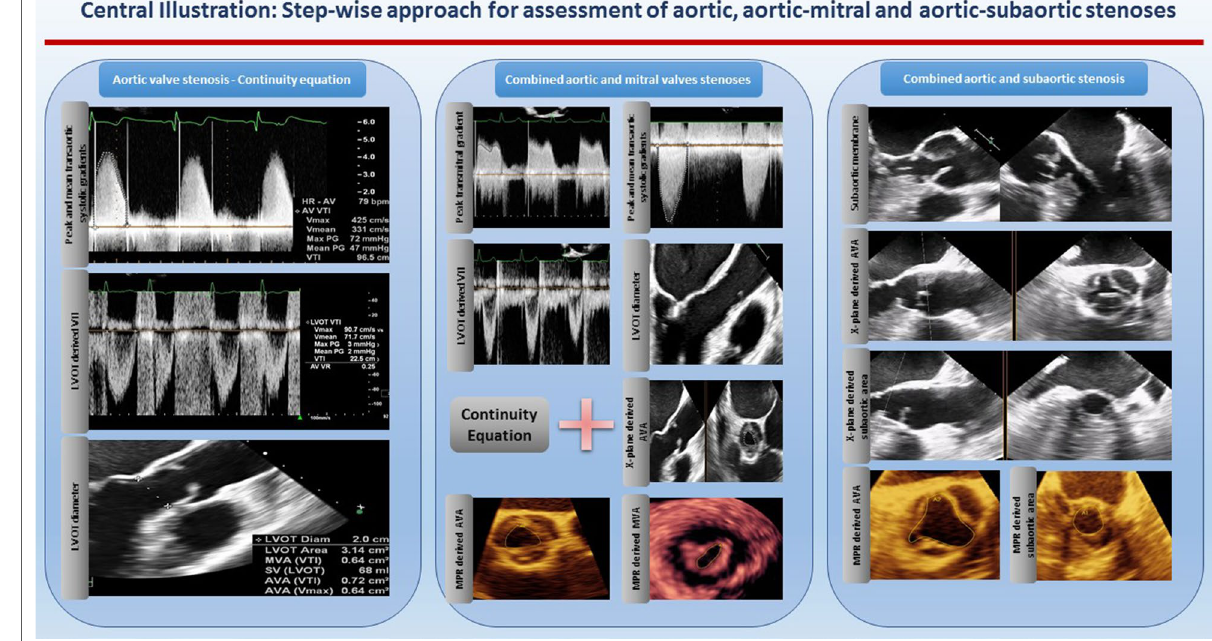
Fig. 15 Stepwise approach for the assessment of aortic–mitral and aortic–subaortic